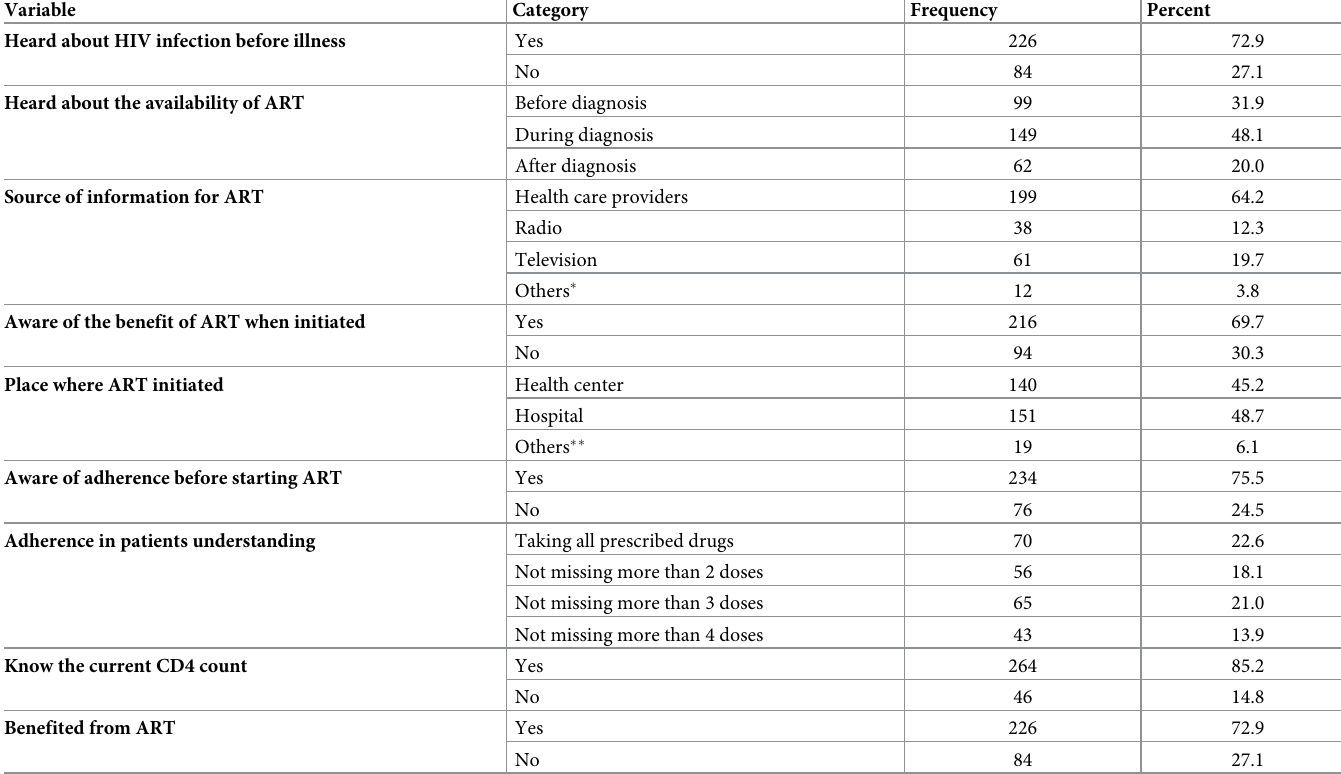
Table 2. HIV/AIDS and ART service-related information of adults on first-line ART at public health facilities of North Shewa Zone, Amhara Regional State, Ethio- pia,